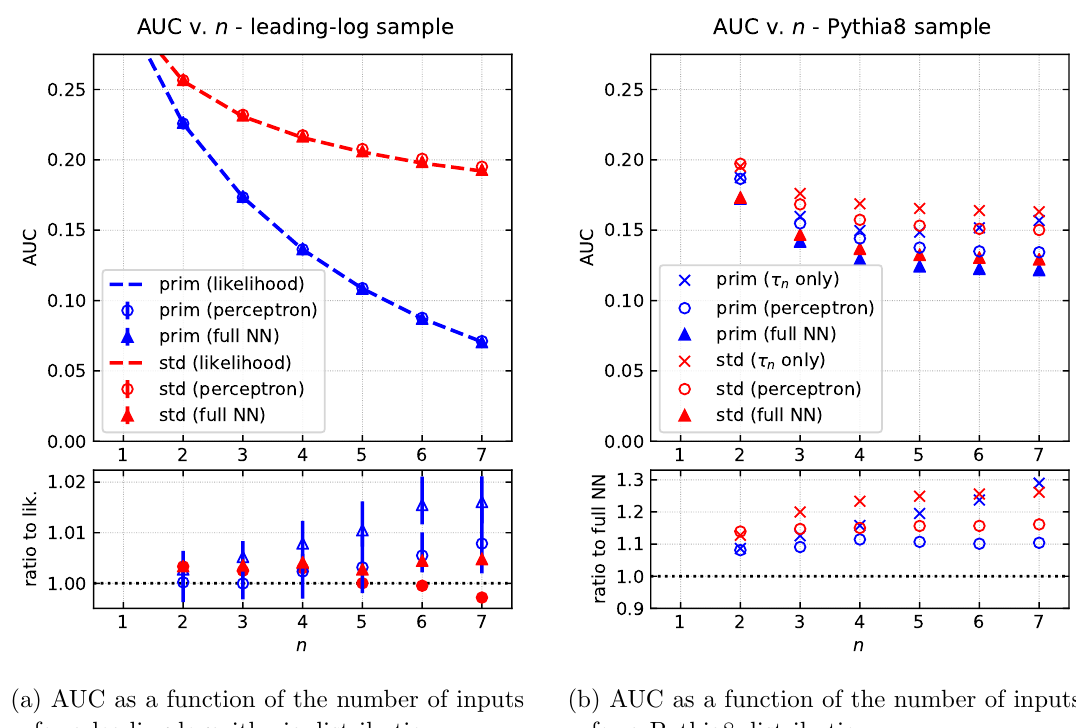
Figure 8 . AUC as a function of the number of inputs n . We show results for both the standard (red) and primary (blue) de(cid:12)nitions of N -subjettiness with training done either for a single perceptron (open circles) or for a full NN ((cid:12)lled triangles). In all cases, log-square inputs have been used. When available, results for the likelihood have been included (dashed lines) and used to normalise the results in the lower panel. When not available, the normalisation is to the full NN results. For the Pythia8 sample we also show the results of a cut on (cid:28) n (or T n ) only